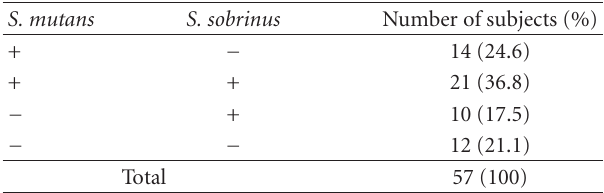
Table 1: Distribution of mutans streptococci at the base